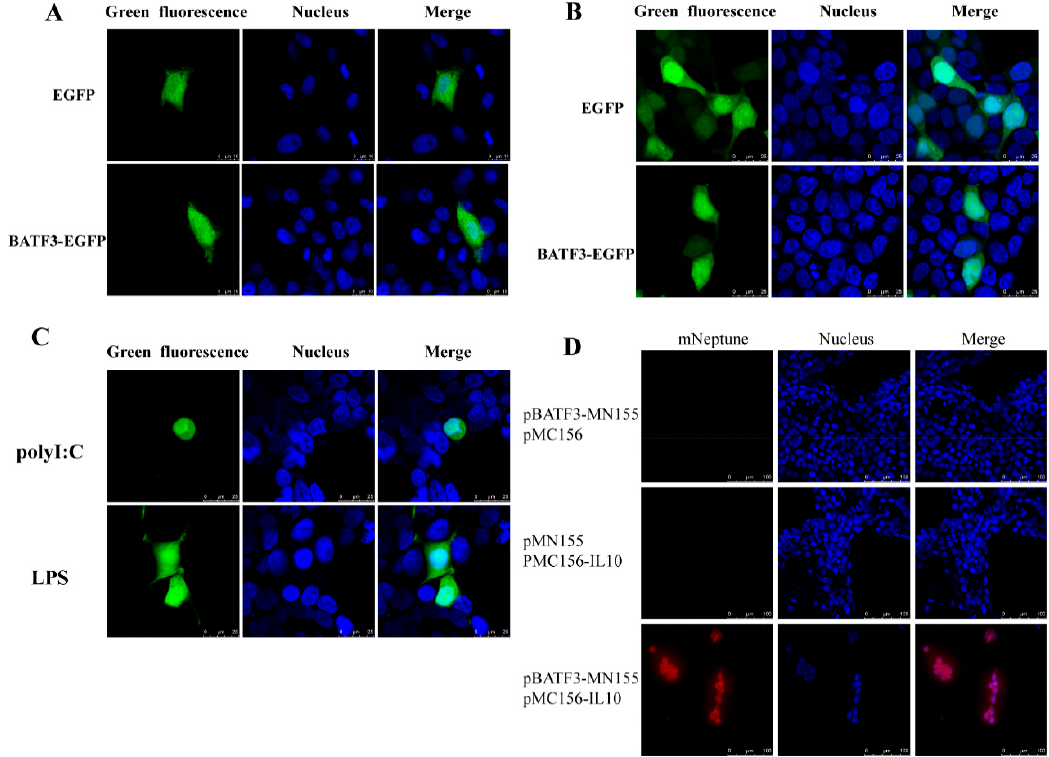
Figure 9. Subcellular localization of CiBATF3 in: CIK cells ( A ); and HEK293 cells ( B ). ( C ) CiBATF3-GFP nuclear translocation induced by PAMPs stimulation. Green fluorescence shows the distribution of EGFP or EGFP-tagged proteins and blue fluorescence shows the nucleus that was stained by Hoechst 33342 under a 60× oil immersion objective lens (scale bars, 10 μ m and 25 μ m). ( D ) Imaging of the protein–protein interaction by using far-red mNeptune-based BiFC in HEK293 cells. The fluorescence of the mNeptune channel was red. The images were acquired using fluorescence microscopy and a 40× oil immersion objective lens (scale bar, 100 μ m).